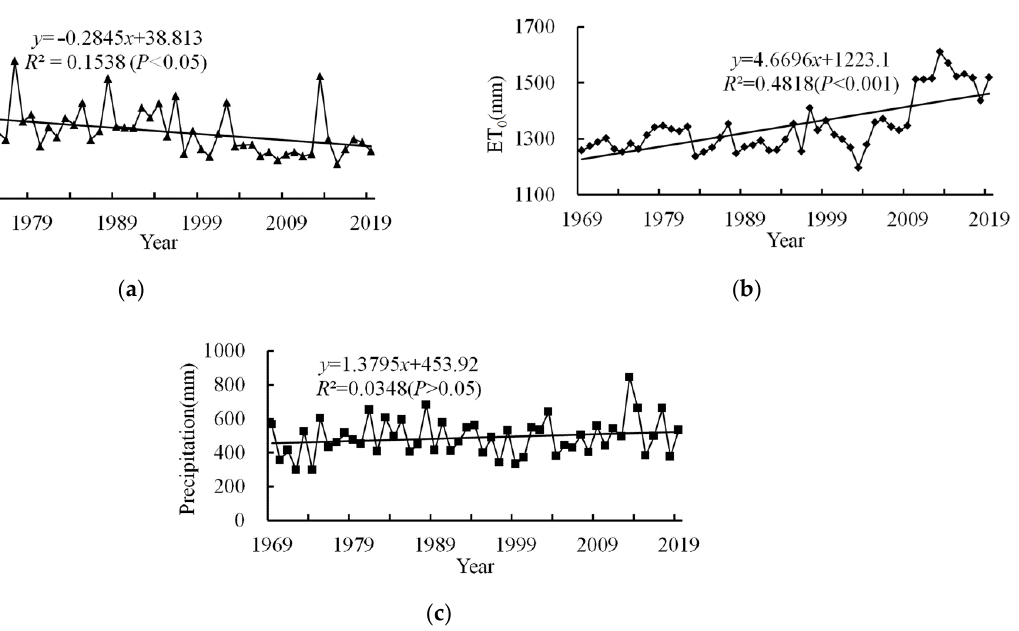
Figure 3. Evolution law of hydrological and meteorological elements: ( a ) runoff; ( b ) ET 0; ( c ) precipitation.